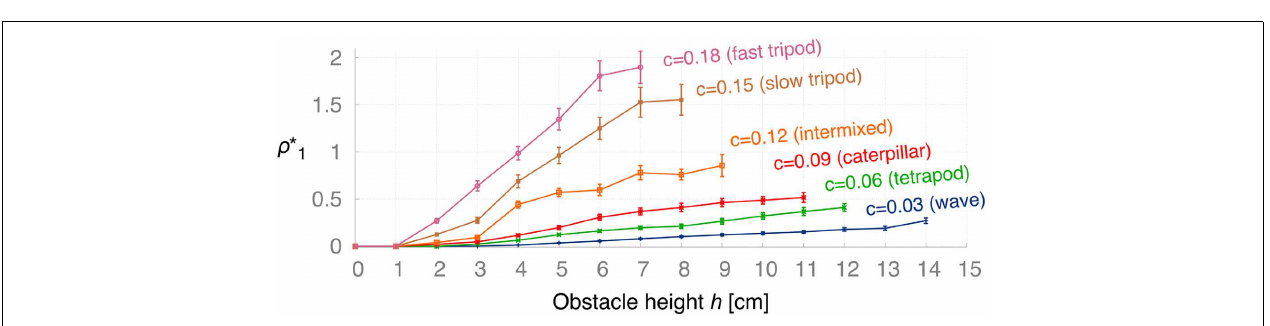
FIGURE 9 | Average learned weights ρ ∗ 1 ( ± SD) with respect to the obstacle height h for different gaits: wave ( c = 0 . 03), tetrapod ( c = 0 . 06), caterpillar ( c = 0 . 09), intermixed ( c = 0 . 12), slow tripod ( c = 0 . 15), and fast tripod ( c = 0 . 18) gait. For increasing h and c the learned weights